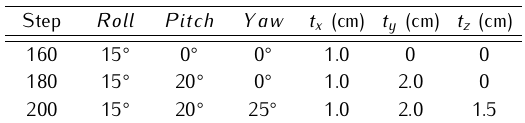
Table 6. Combined Rotational and Translational motion given to the Phantom during scanning of projections at 160°, 180°, and